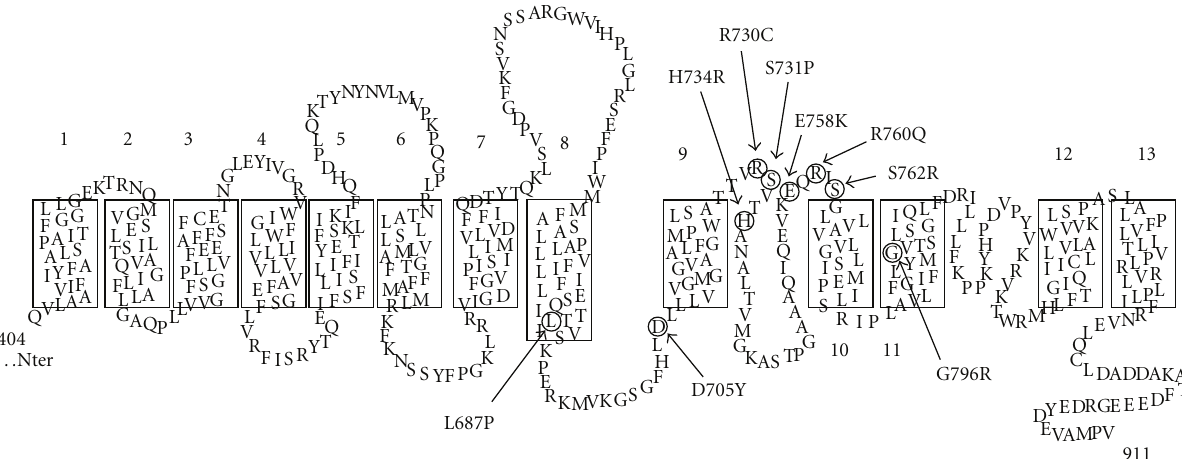
Figure 1: Topology of the membrane spanning domain of human AE1 with 13 α helices, according to Zhu et al. [29]. Amino-acids that are substituted in response to the di ff erent point mutations in AE1 gene are labelled by circles. Each of these mutations is associated with hereditary haemolytic anaemia characterized by cation leaky red